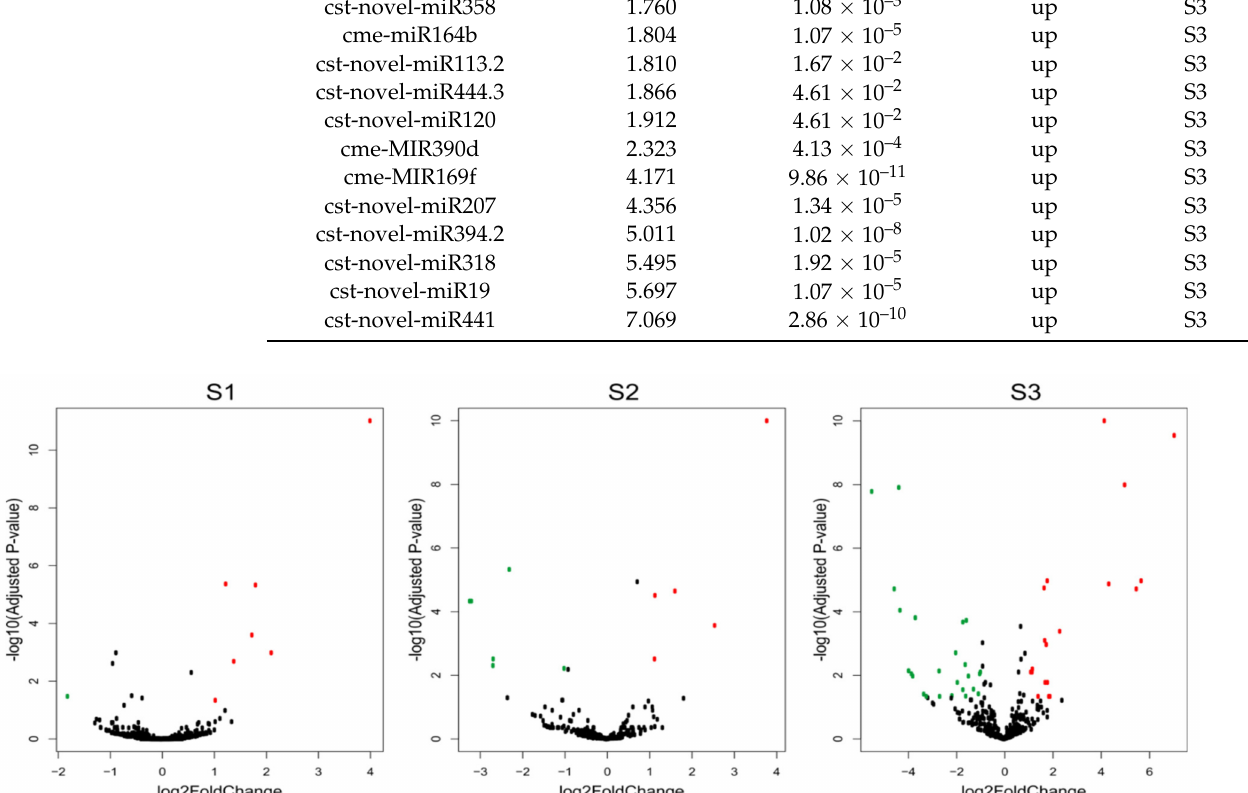
Figure 4. Volcano plots of differentially expressed miRNA in three cucumber somaclonal lines (S1, S2 and S3) versus control B10 line. Green dots represent significant down-regulated miRNAs, red dots represent significant up-regulated MiRNAs, and black dots represent no significant miRNA expression.